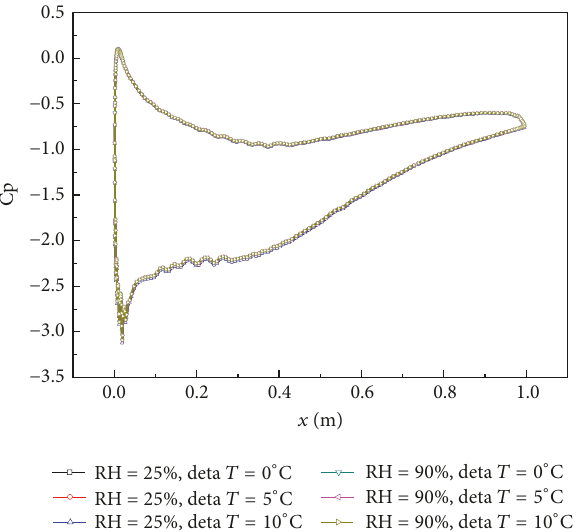
Figure 7: Pressure coefficient around airfoil for RH = 25% and RH = 90% using VF